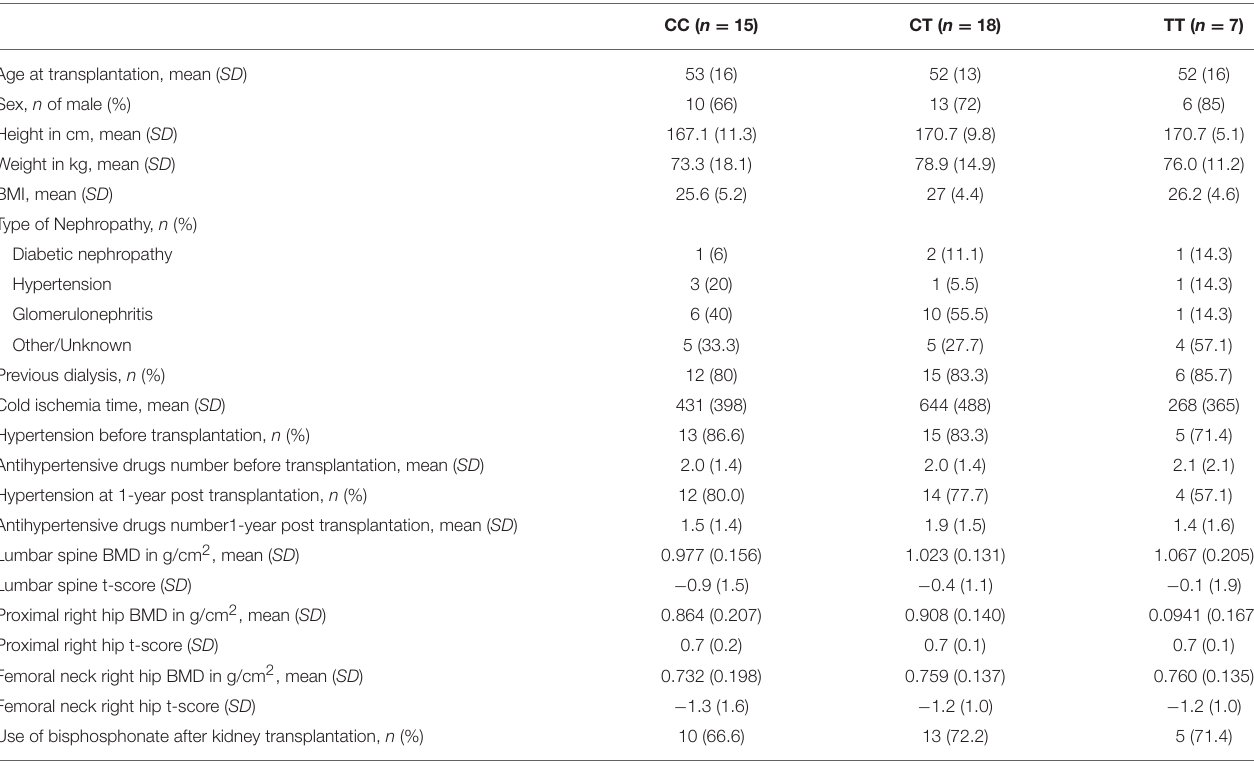
TABLE 1 | Baseline patient characteristics by genotype ( n = 40).